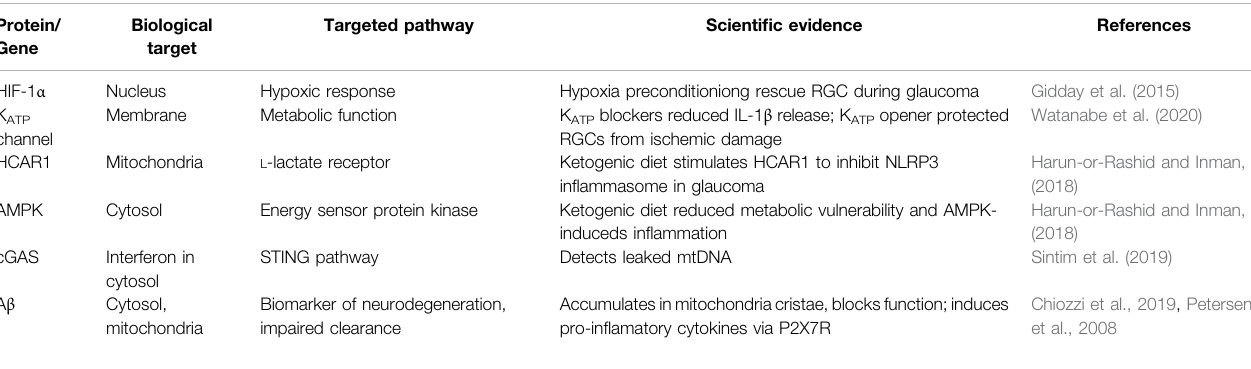
TABLE 1 | Pharmacological targets to ameliorate mitochondrial dysfunction and in fl